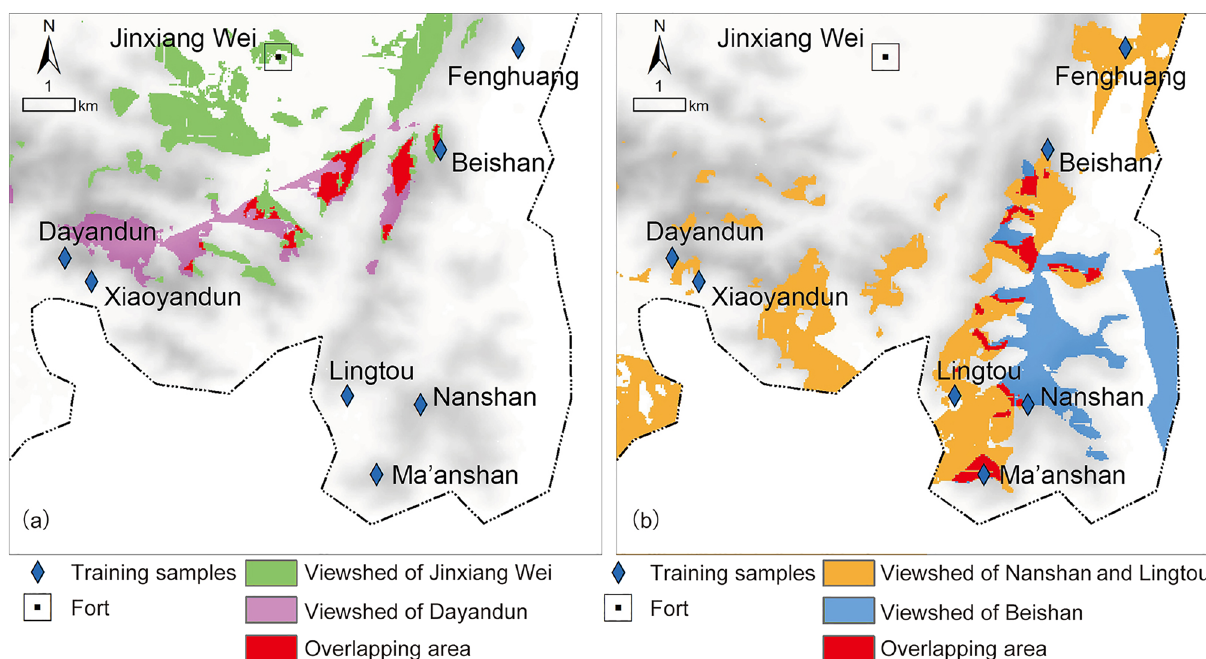
Figure 8. Viewshed analysis results: ( a ) the viewshed area of Jinxiang Wei and Dayandun Beacon; ( b ) the viewshed area of Nanshan Beacon, Lingtou Beacon and Beishan Beacon (generated by the authors using ArcGIS